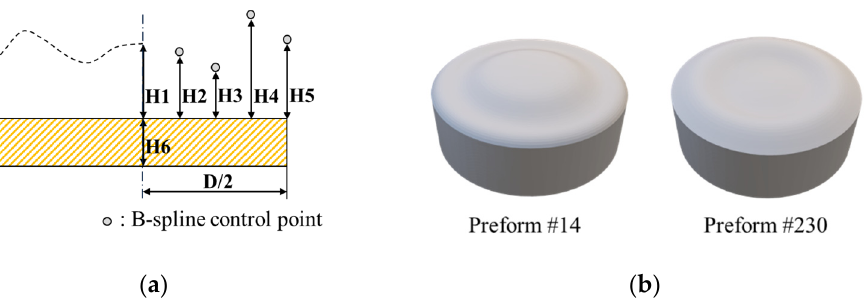
Figure 6. ( a ) B-spline method for the preform shapes, and ( b ) preform #14 and #230 (examples).